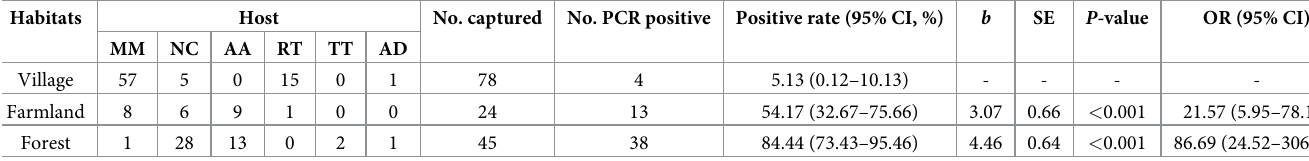
Table 2. Positivity rate of Bartonella infection of small rodents in different